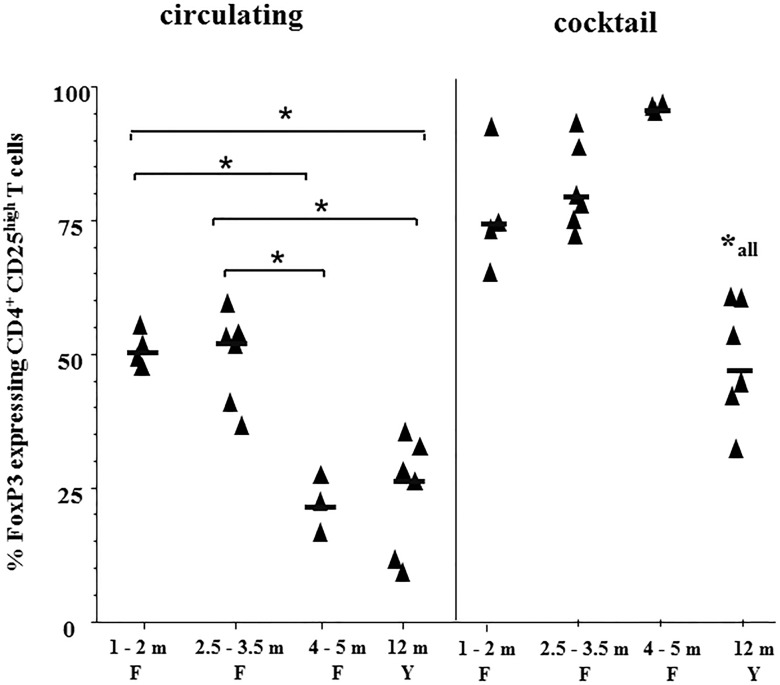
Influence of the age of foals on the proportion of CD4+CD25high FoxP3+ cells.Results from foals and yearlings reported in Figs. 1 and 2 were grouped according to their age into four categories: Foals, 1–2 months (F), 2.5–3.5 months, 4–5 months and yearlings 12 months (Y). The effect of the age group on the percentage of CD4
+
CD25
high
FoxP3
+ cells (circulating) in freshly isolated as well as cocktail stimulated (cocktail) PBMC was examined using one way ANOVA. Comparisons between the four groups were performed using Kruskal-Wallis Multiple-Comparison Z value Test with Bonferroni correction. Each data point represents 1 horse, horizontal bars within values denote medians. An asterisk with line indicates statistical significance difference between the groups of horses. *all indicates significant difference of yearlings to the 3 groups of foals. *p ≤0.05 was considered significant.